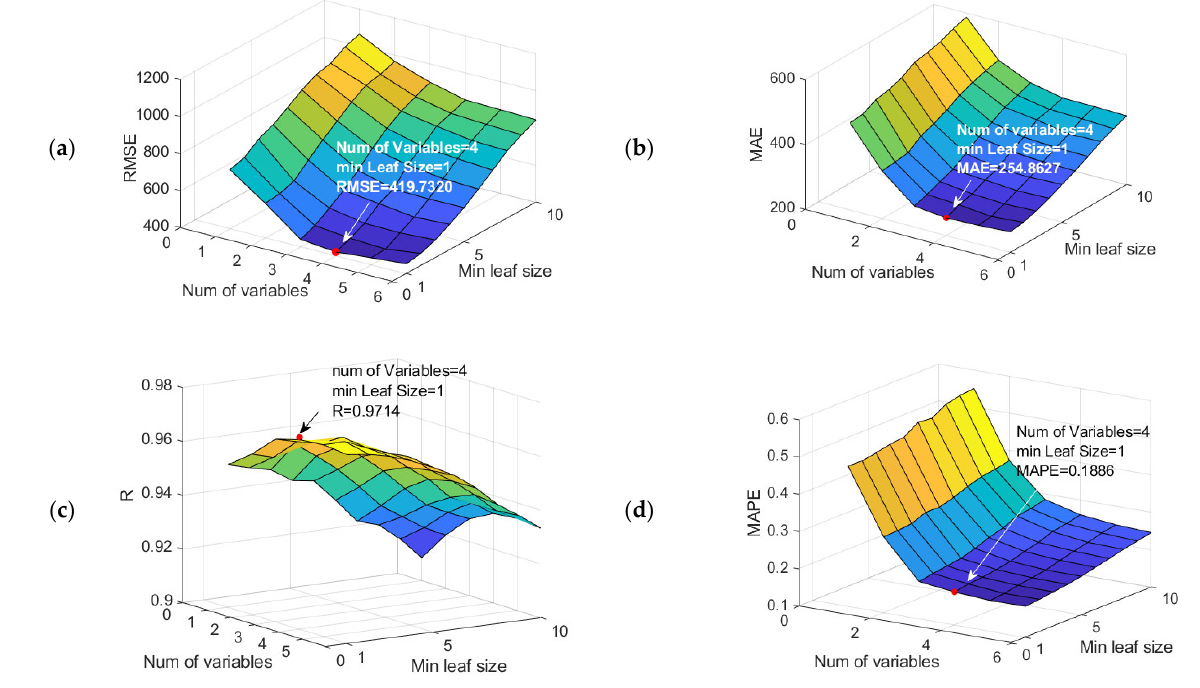
Figure 10. Accuracy analysis of ensembles based on regression trees: ( a ) RMSE, ( b ) MAE, ( c ) R, and ( d ) MAPE.